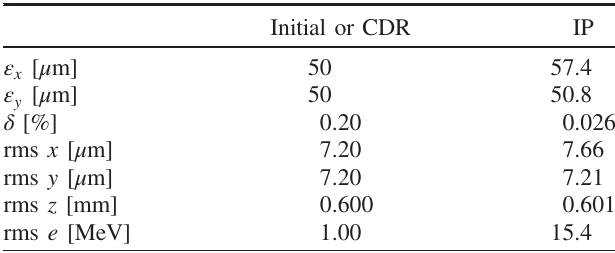
TABLE IV. Initial beam parameters compared to the ones at the IP in the presence of synchrotron radiation.